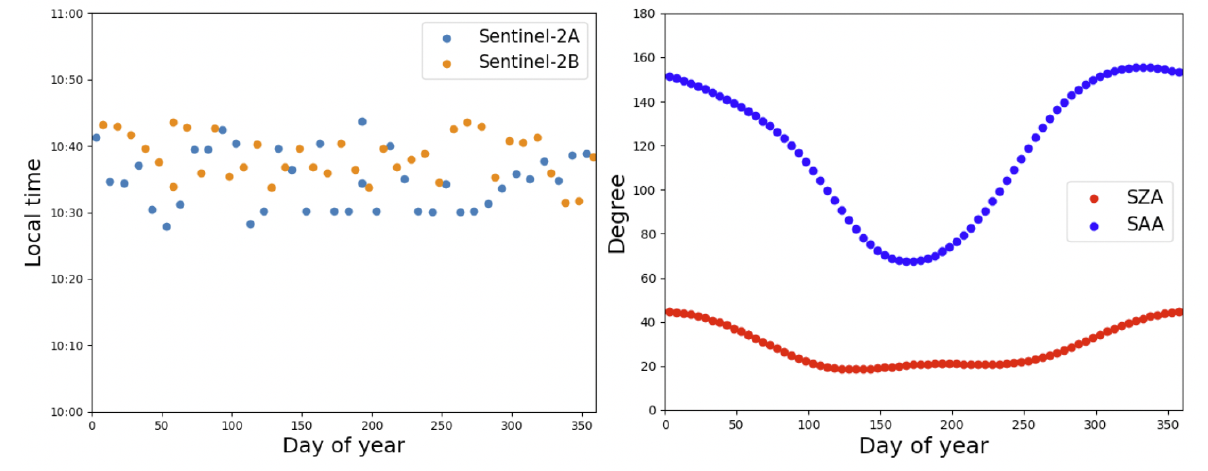
Figure 2. Sentinel-2A/B local overpass time in 2019 ( left ) and Sun zenith angle and Sun azimuth angle during the time of Sentinel-2A/B overpass in the target area ( right ).